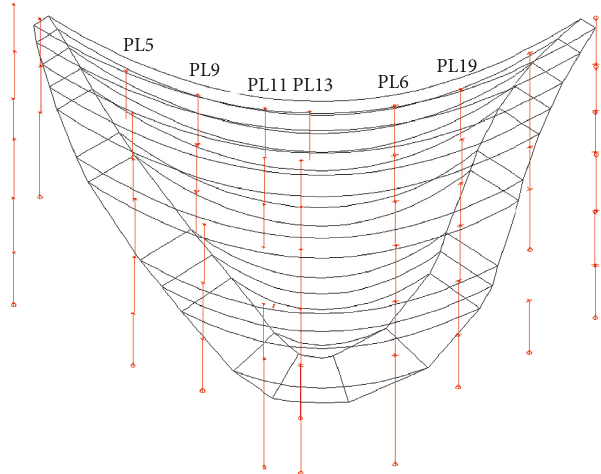
Figure 5: Pendulum system of some main dam sections.